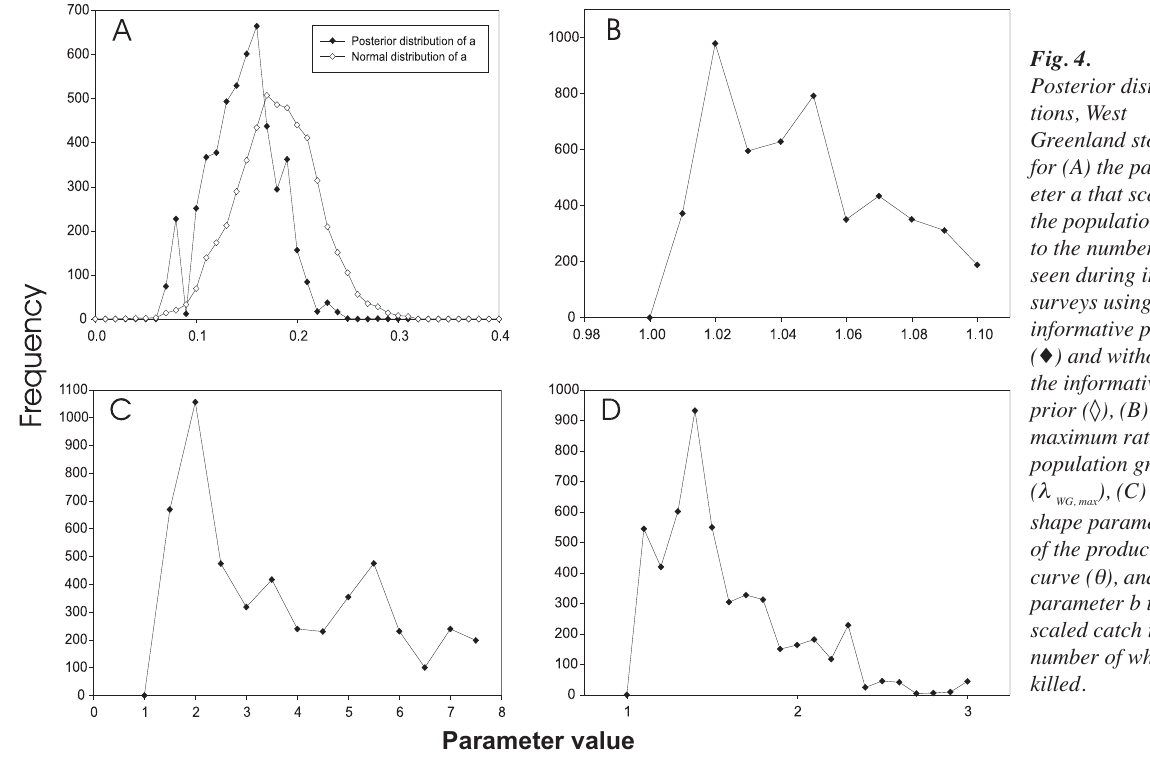
Fig. 4. Posterior distribu- tions, West Greenland